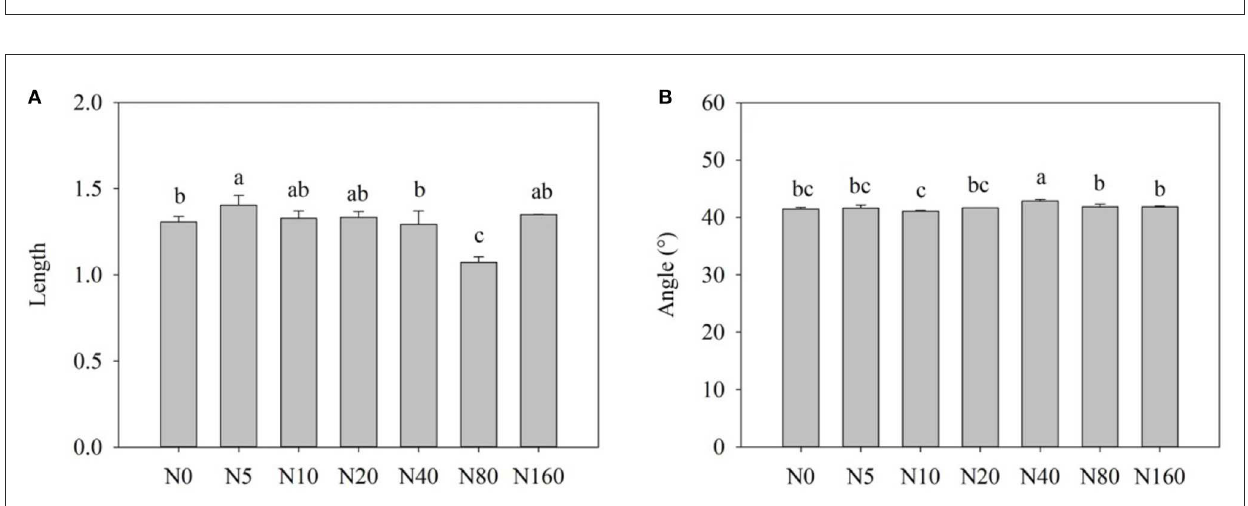
FIGURE4 Effect of nitrogen addition on the length (A) and angle (B) of enzyme activity vector.